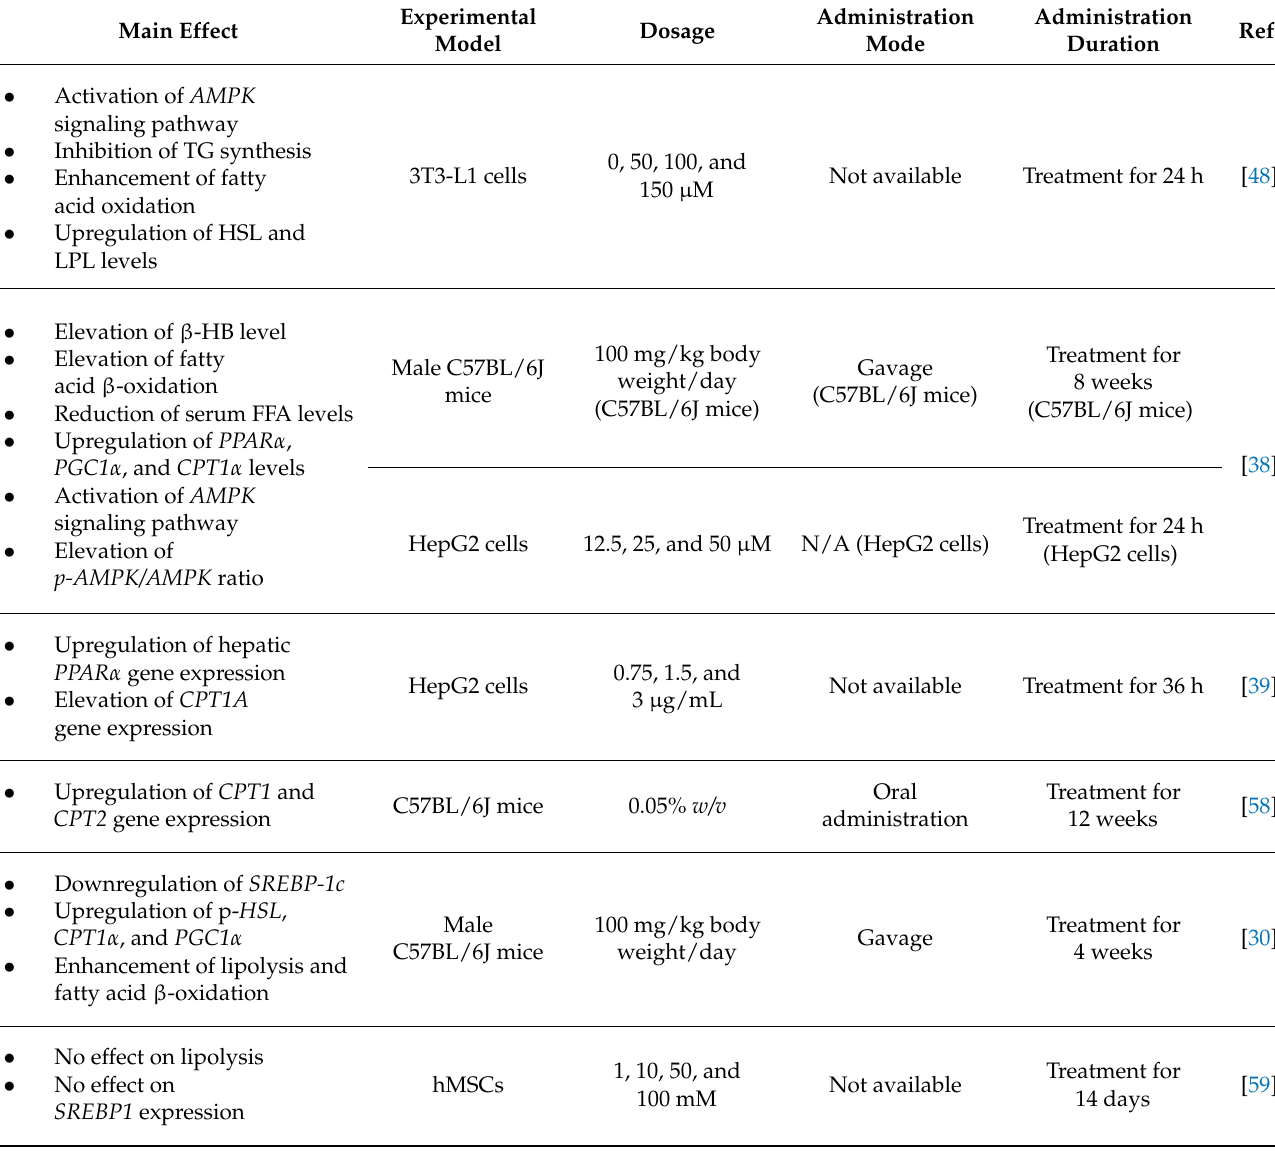
Table 3. The effects of sesamol on fatty acid